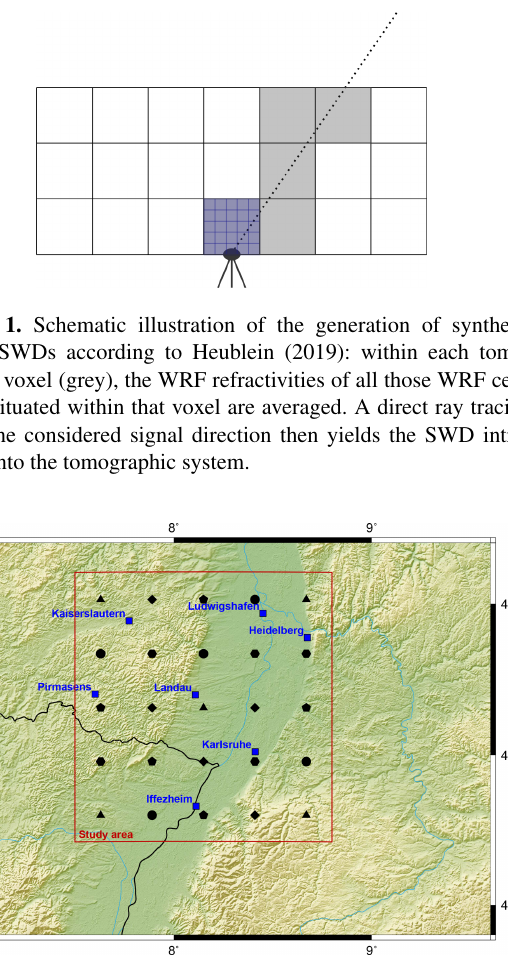
Figure 2. Distribution of the 7 GNSS permanent sites (blue squares) as well as of the 5 to 25 additional, synthetic sites (black symbols) within the URG study area. The additional, synthetic sites are dis- tributed within a grid that uniformly covers the study area. Trian- gles, pentagons, hexagons, diamonds, and circles represent the first, second, third, fourth, and fifth group of five additional sites